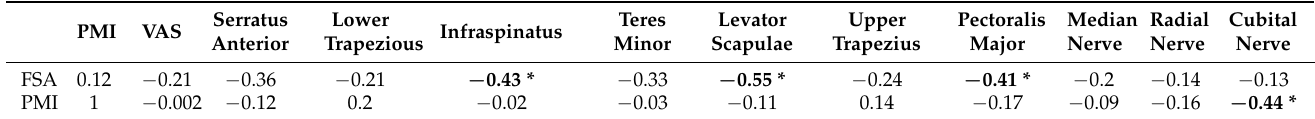
Table 3. Spearman’s Rho correlations in Shoulder pain Group.